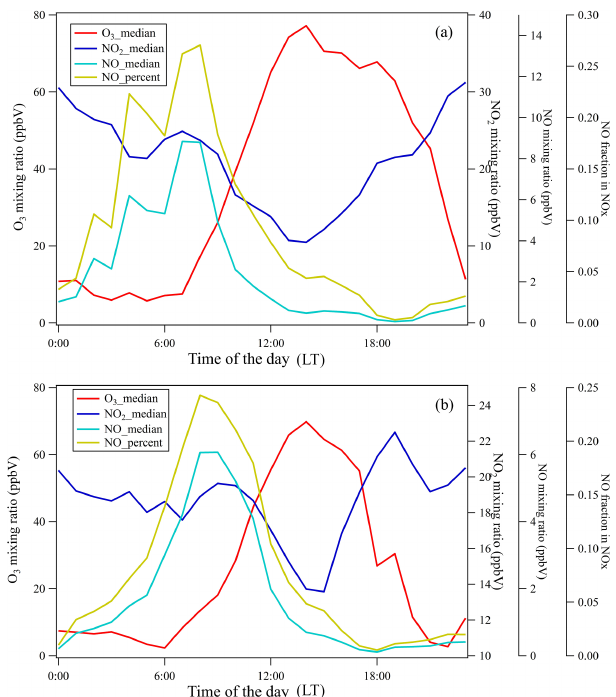
Figure 6. Diurnal variations of O 3 , NO, NO 2 and relative contribu- tion of NO to NO x in Beijing in 2013 (a) and Heshan in 2014 (b)